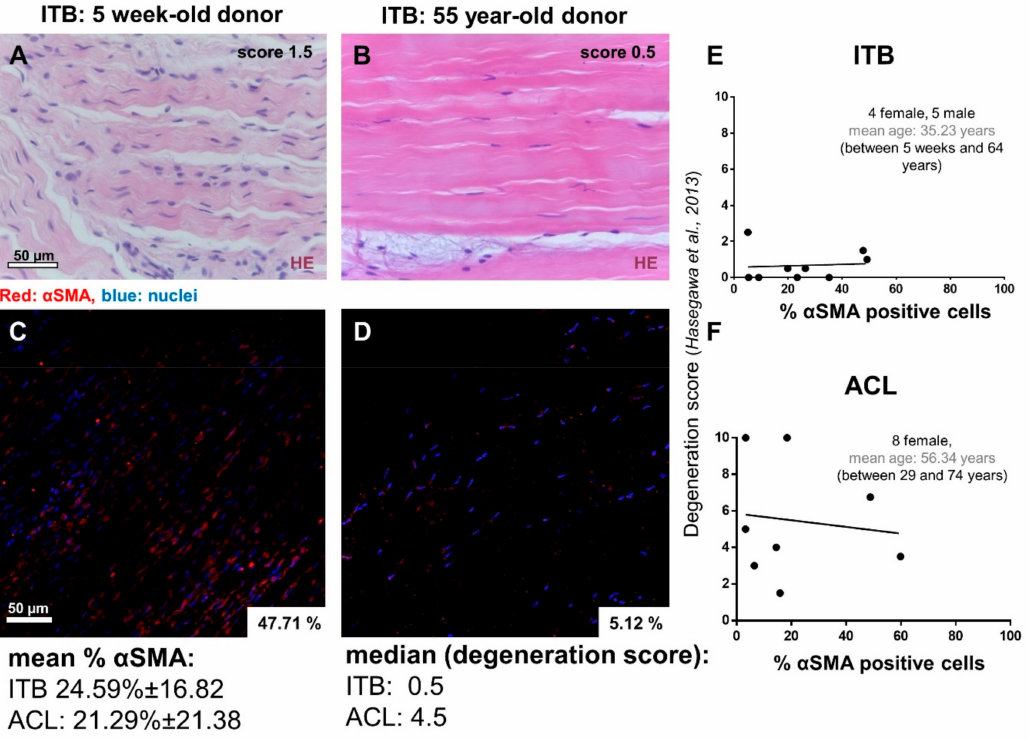
Figure 2. Representative ITB samples stained with hematoxylin eosin (HE) and immunolabeled for α -smooth muscle actin ( α SMA). ( A , B ) A representative HE staining of ITB tissue of a young and aged donor. ( C , D ) α SMA-staining of the same samples. No significant correlation could be shown between the stage of degeneration and the percentage of α SMA expressing cells for ITB ( E ) (spearman: r = 0.149, p = 0.701) and ACL ( F ) (spearman: r = − 0.096, p = 0.806) tissue samples. Scale bars: 50 µ m. ITB: iliotibial band, ACL: anterior cruciate